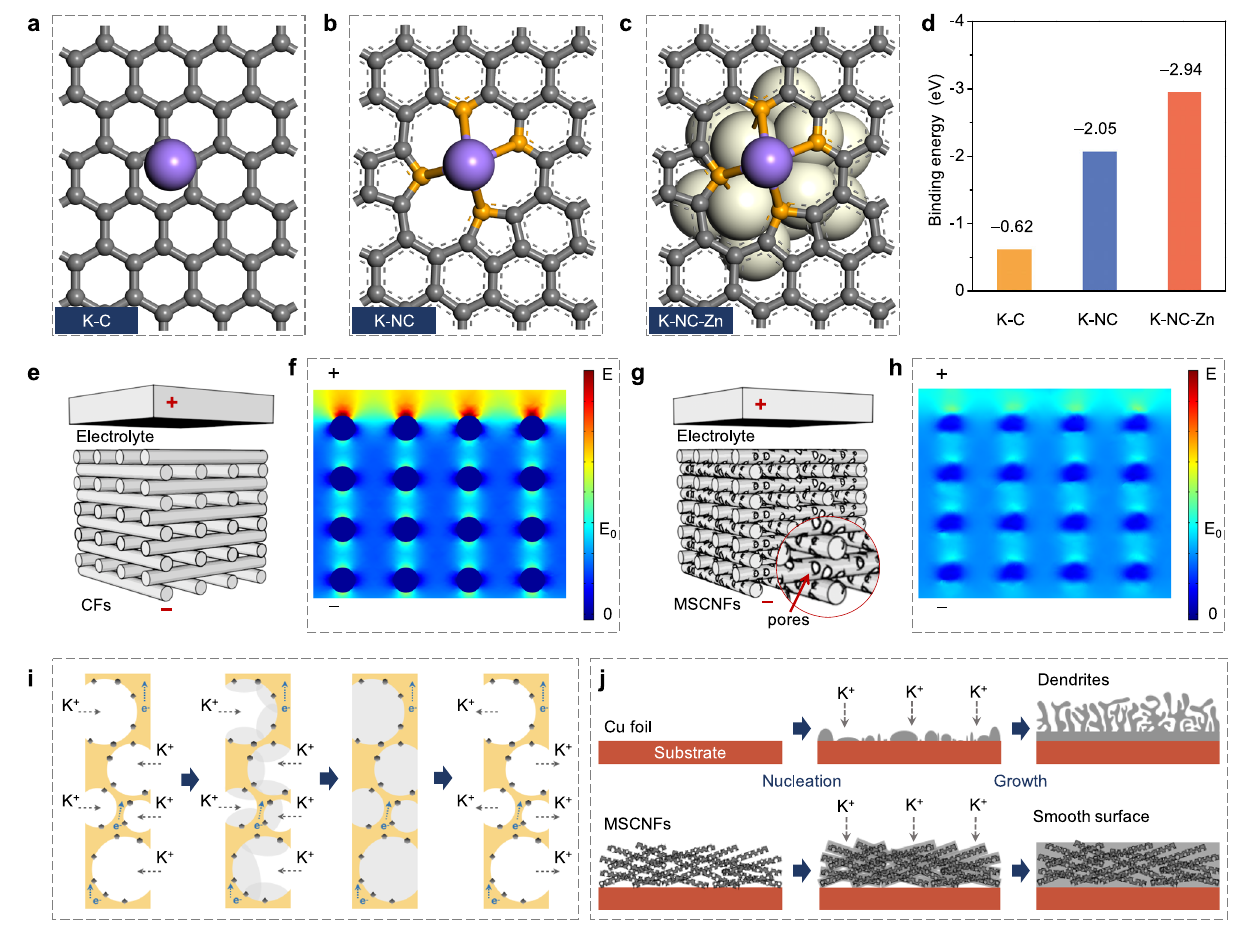
g MSCNFs and corresponding E- fi eld distributions of the f CFs and h MSCNFs. Schematicillustrationof i KplatingandstrippingonMSCNFsand j Kdepositionon different